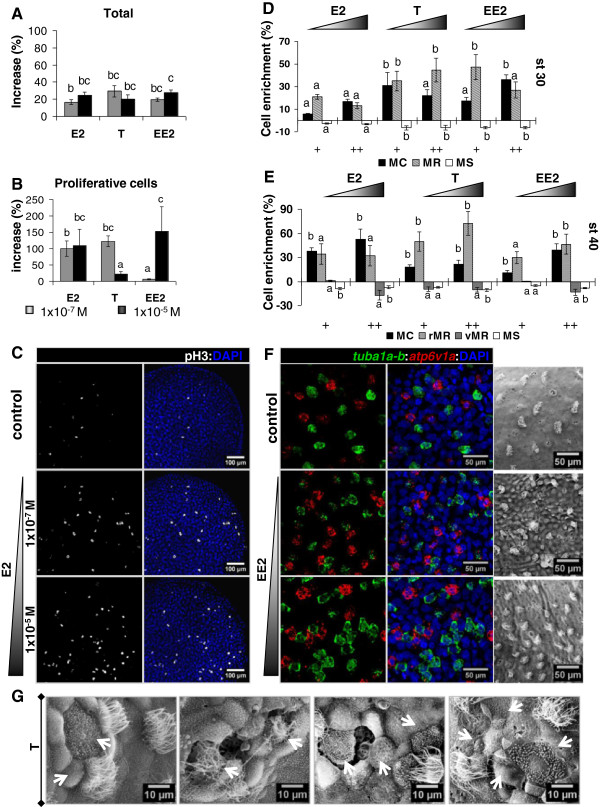
Effects of sex steroids on the MCE cellular ecosystem. A,B) Effects of estradiol (E2), testosterone (T) and ethynyl-E2 (EE2) on the total cell abundance in MCE, based on DAPI nuclei staining (A), and on the total amount of proliferative cells (pH3 positive/field) (B). Analyses by confocal microscopy in embryos at st 30, d.f. = 21. C) Proliferative cells in E2 treated MCE from ectoderm explants. IHC for pH3 and DAPI. Confocal microscopy, 2 μm stack. Data representative of 18 samples/condition. D,E) Changes in cell population enrichment mediated by sex steroids in Xenopus epidermal MCE. Data based on the ratio of cell counting of each population over the total number of cells at st 30 (DAPI) (D) or st 40 (SEM micrographs) (E). Data are representative of 48 (st 30, Confocal imaging of molecular makers) or 24 (st 40) embryos by sex steroid treatment. +/++ concentrations = 1x10-7 M / 1x10-5 M. MC = multiciliated, vMR or rMR = vesicle or ridged mitochondrion-rich, MS = mucus-secreting cells. A,B,D,E) Baseline established for control group = 0. Mean ± SD, “a” = control group; Letter code: a indicates no difference with control, all other letters indicate significant difference with the control, shared letters indicate no significant differences between the corresponding conditions. One-way ANOVA, Tukey comparison test, p < 0.05. F) Disruption of cell population arrangement caused by EE2 in embryos at st 30. We observed an increase of MC (tuba1a-b, green) and MR (atp6v1a, red) cells, and the presence of adjacent MC cells. Double FISH and DAPI. Confocal microscopy, 2 μm stack, 24 embryos/condition. Right panels: Increase of the number of MC cells and disrupted epithelial architecture caused by EE2 SEM, st 40, 16 embryos/condition. G) Perturbed epidermal MCE arrangement and morphology provoked by T. SEM, st 40, 16 embryos/condition.